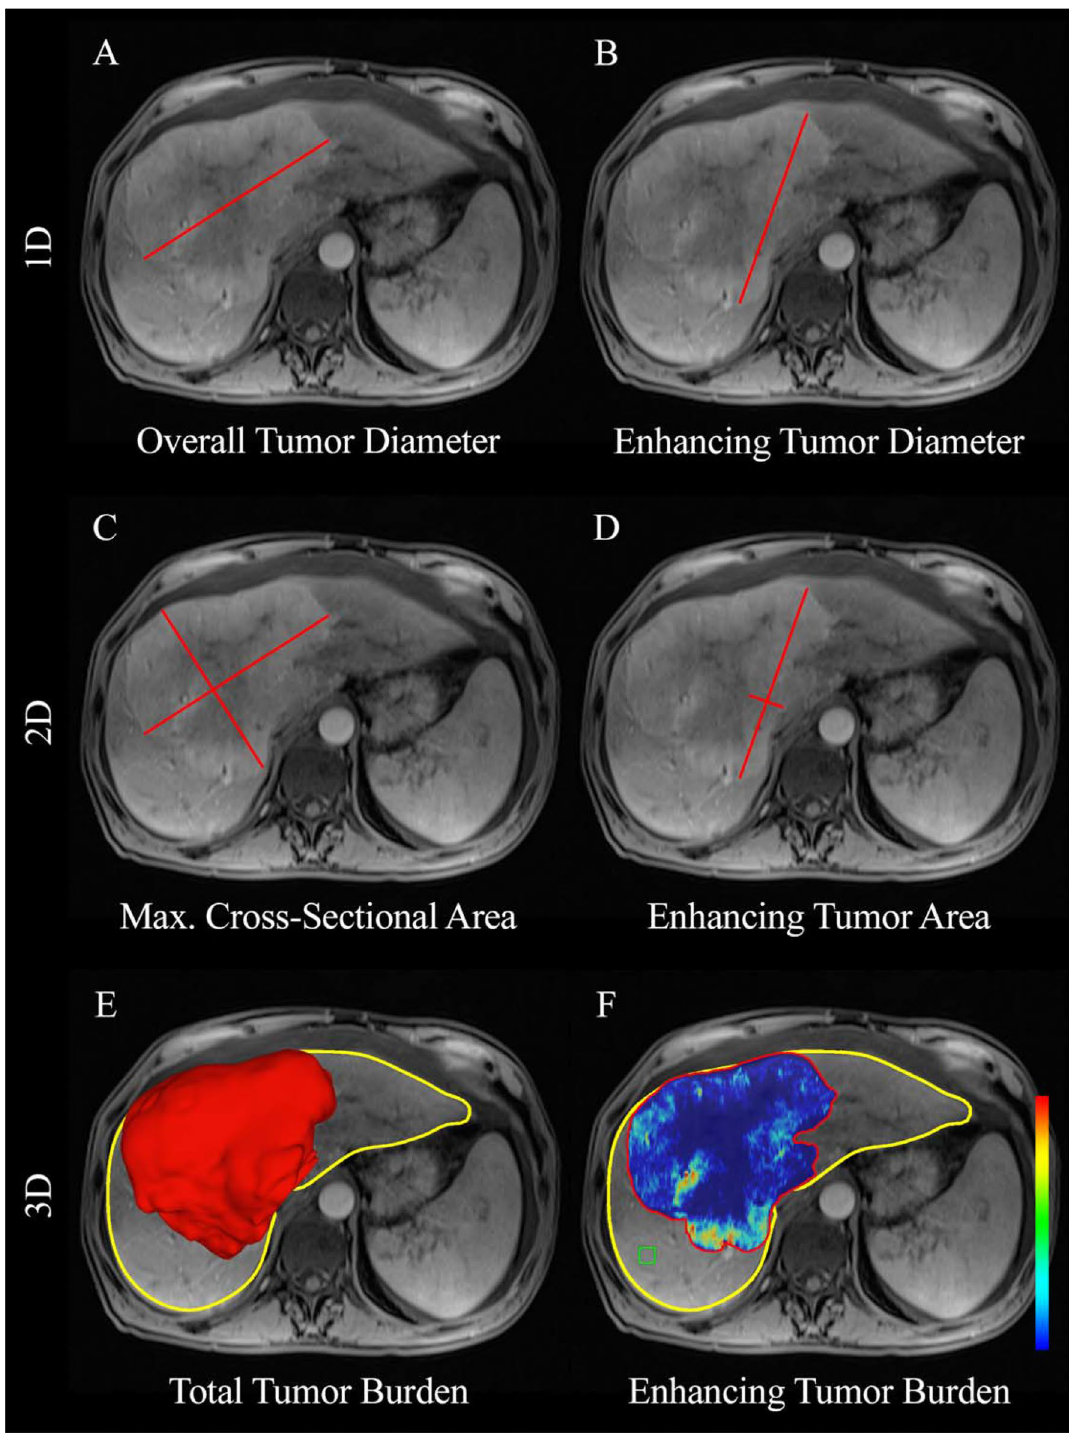
Figure 4. Methods of tumor assessment on enhancement-based MRI. ( A,B ) Demonstrate 1D measurements showing the largest overall tumor diameter (cm) and largest enhancing tumor diameter (cm) represented by the red line. ( C,D ) Show the 2D tumor measurement methods and represent the maximum cross-sectional area (cm 2 ) and maximum enhancing tumor area (cm 2 ). ( E ) Segmentation of the tumor (3D reconstruction in red) showing the total tumor volume (cm 3 ) in relation to the total liver volume (cm 3 ), shown by the yellow outline. ( F ) Assessing enhancing tumor volume (cm 3 ). Dark-blue regions of the color map represent necrotic tissue; red regions show viable tumor tissue, as described in previous literature 19 . The region of interest (ROI) represented by the green 1 cm 3 box is used as the relative baseline enhancement of healthy liver parenchyma to calculate the differential enhancement within the segmentation-mask of the